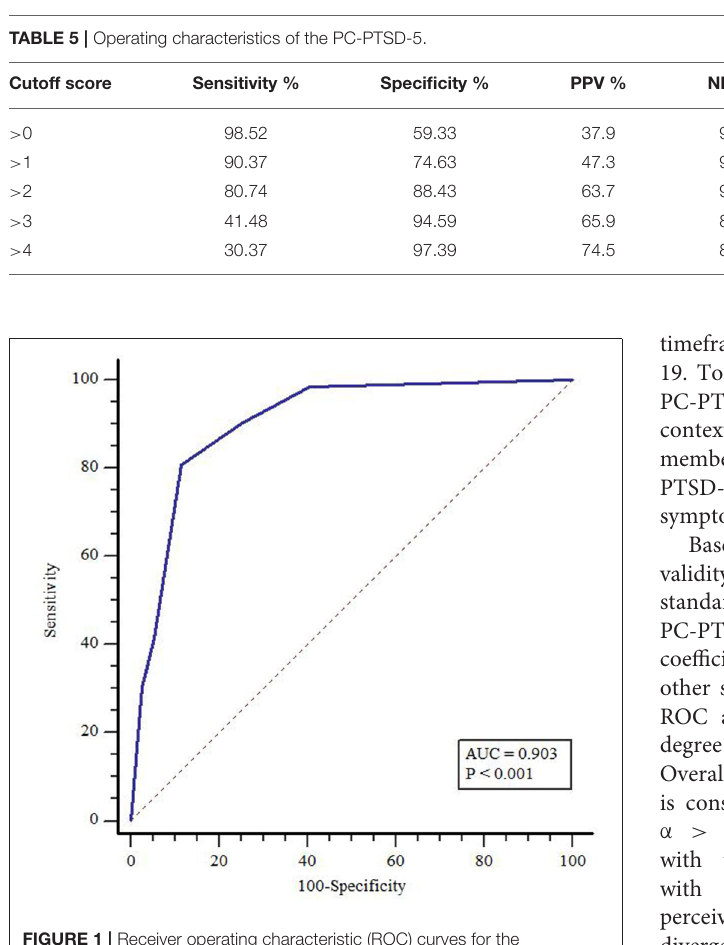
FIGURE 1 | Receiver operating characteristic (ROC) curves for the